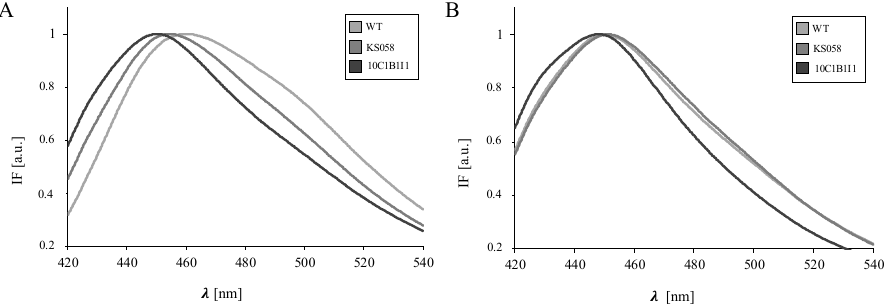
Figure 3. The representative, normalized fluorescence intensities (IFs) spectra for a Laurdan fluorescent probe incorporated into the plasma membrane of the C. albicans SC5314 (WT), erg11 Δ / Δ (KS058), and ERG11 K143R/K143R (10C1B1I1) strains in control conditions at 8 h ( A ) and 24 h ( B ). For C. albicans KS058 and 10C1B1I1, we detected a red shift for Laurdan IF at 8 h of 24 h of culture (Table 2) and this was expressed in a deepened red shift of the Laurdan IFs (Figure 3B). However, the overproduction of ergosterol in the 10C1B1I1 strain resulted in 1.4-fold lower fluidity of the PM (positive GP value) comparing to the WT and KS058 strains.